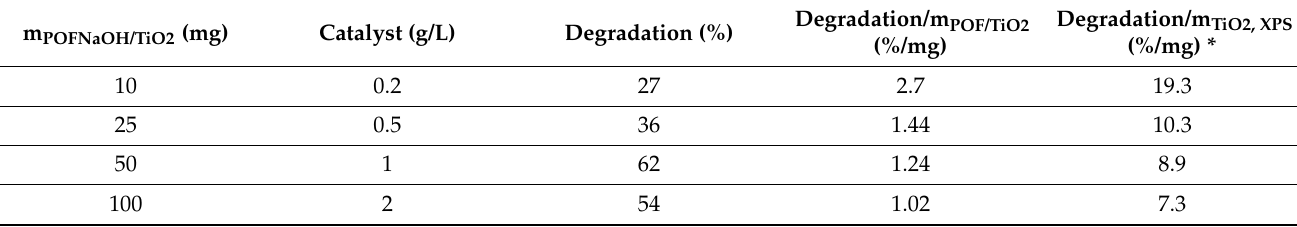
Table 2. Effect of POF/TiO 2 concentration ([Phenol] 0 = 50 mg/L; λ = 254 nm; V phenol = 50 mL; pH = 6.7, t = 4 h) on photocatalytic